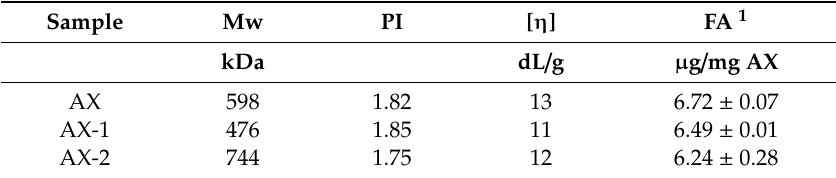
Table 1. Macromolecular features of arabinoxylans (AX).